Question: What kind of plot is shown here?
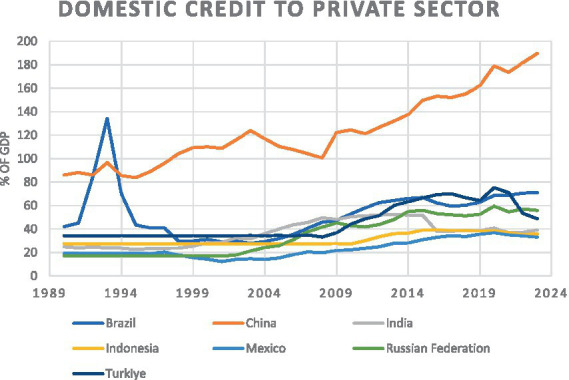
Answer: line